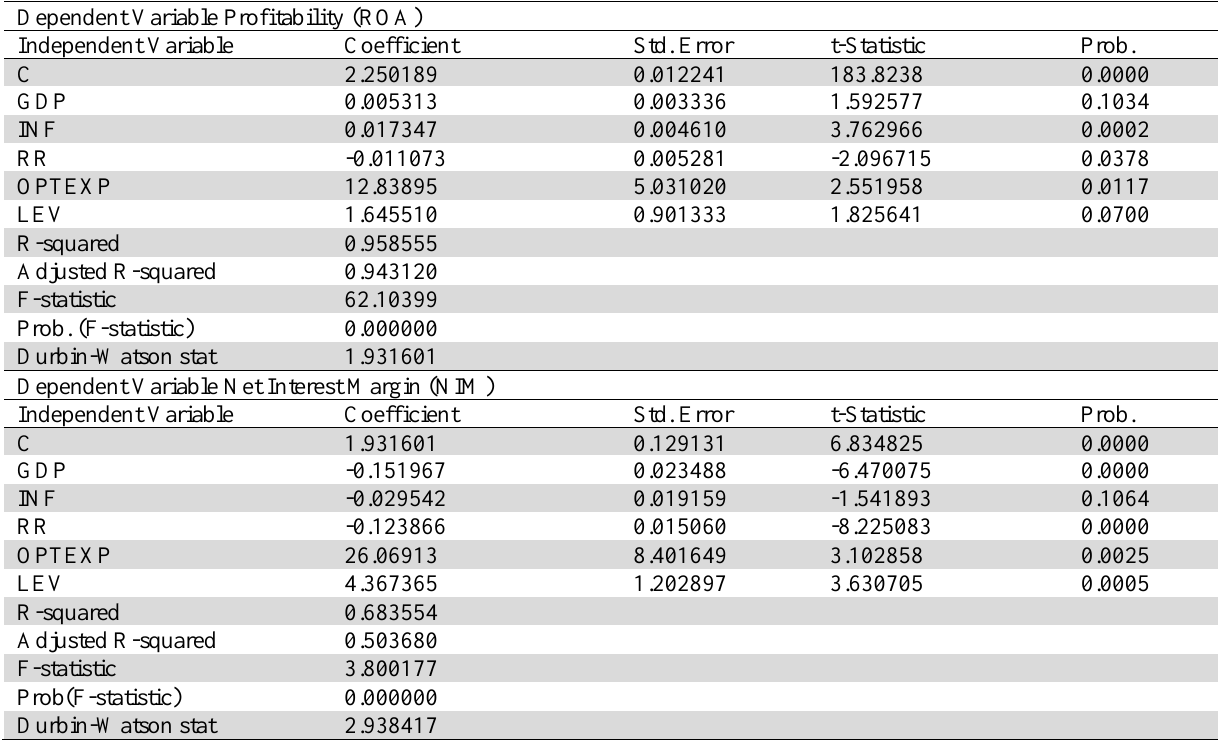
Fixed Effect Model